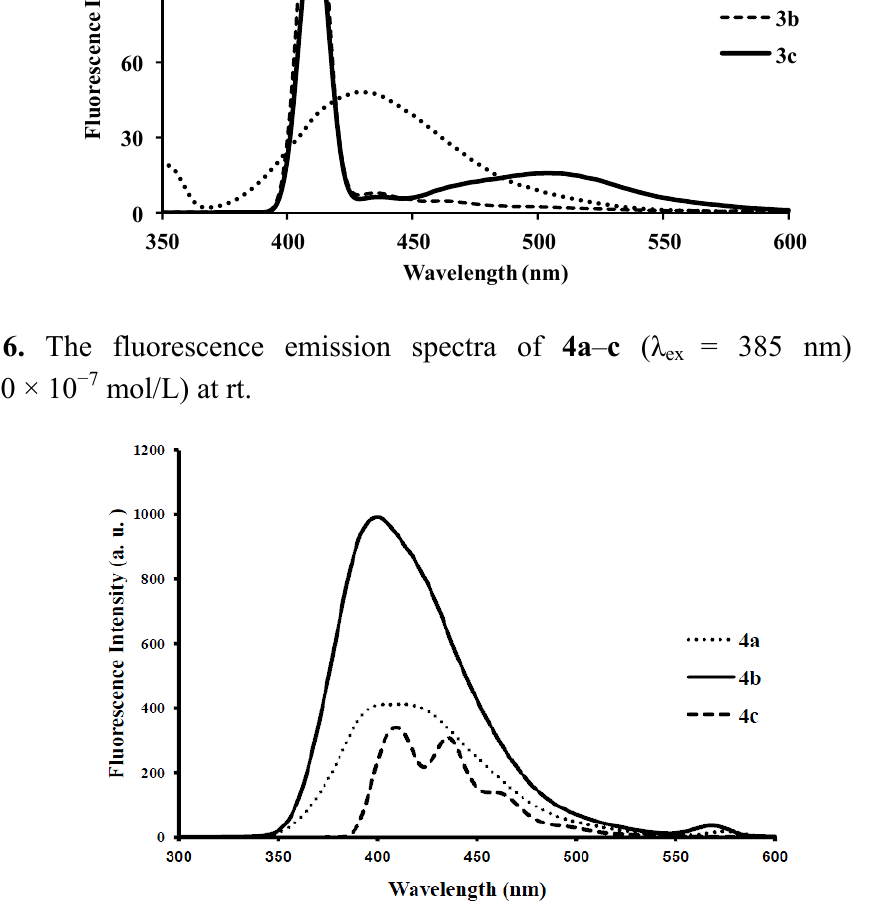
Figure 5. The fluorescence emission spectra of 3a – c ( λ (conc. 2.0 × 10 − 7 mol/L) at rt.